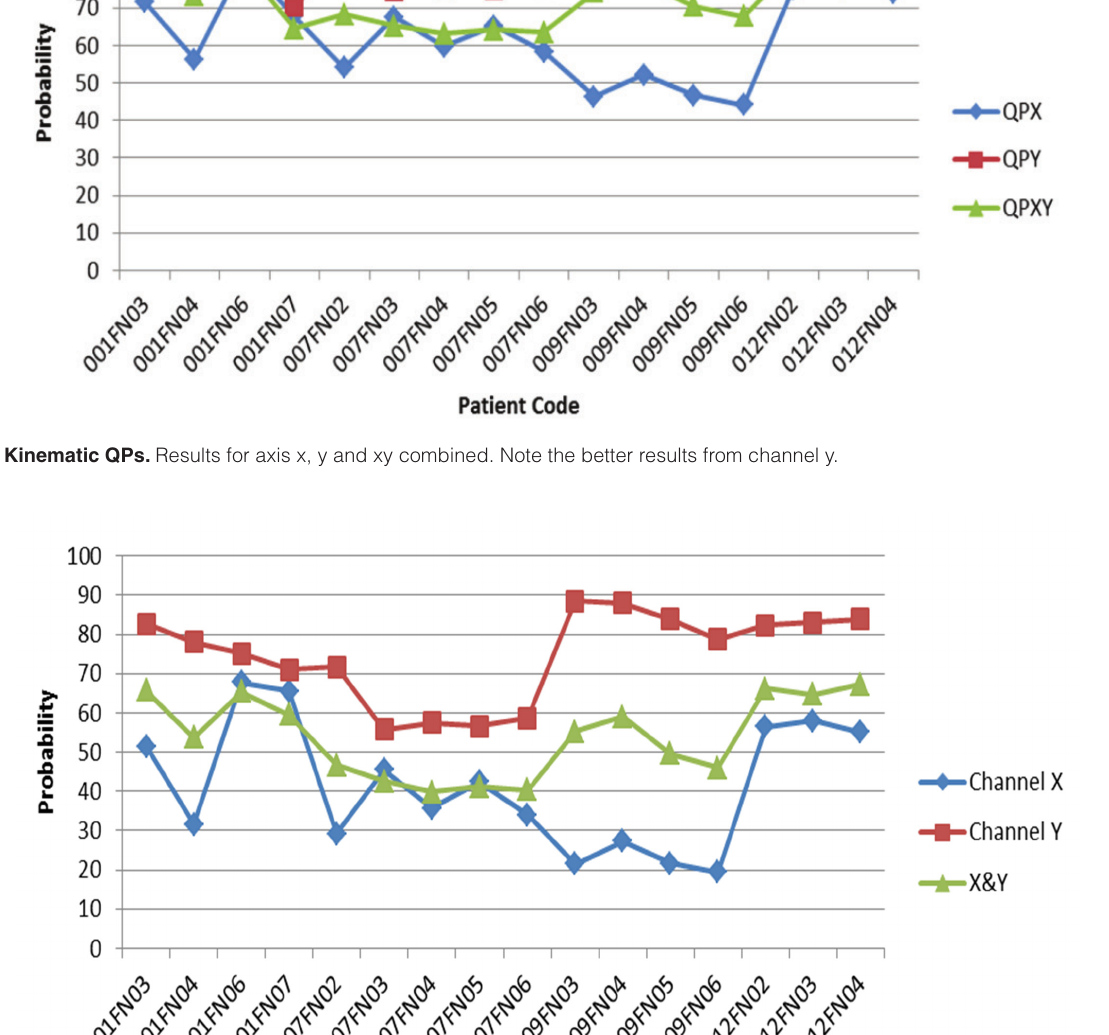
for the QP for a threshold of desynchronization set as -4.8 and 9.5 for the simple and squared ratio, respectively. The threshold var- performed a simulation for 2875 trials similar to the trial shown in Figure 12. Figure 13 illustrates how QP evolved as a function of the threshold values used. The traces of averaged QPs were character- ized by values around 70% (Figure 14). Very interestingly, these values are much greater than the values obtained for the cortico- muscular module